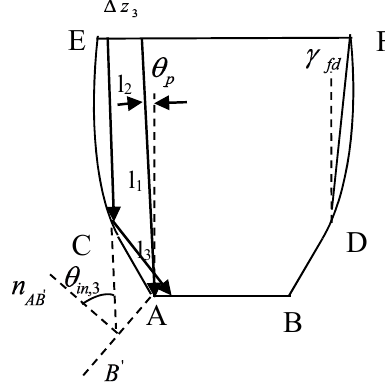
Figure 7. Irradiation situation of left plane wall as θ p ≤ γ fd